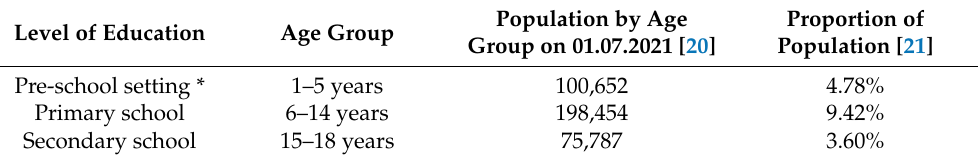
Presentation of age groups of children and adolescents by level of education in the Republic of